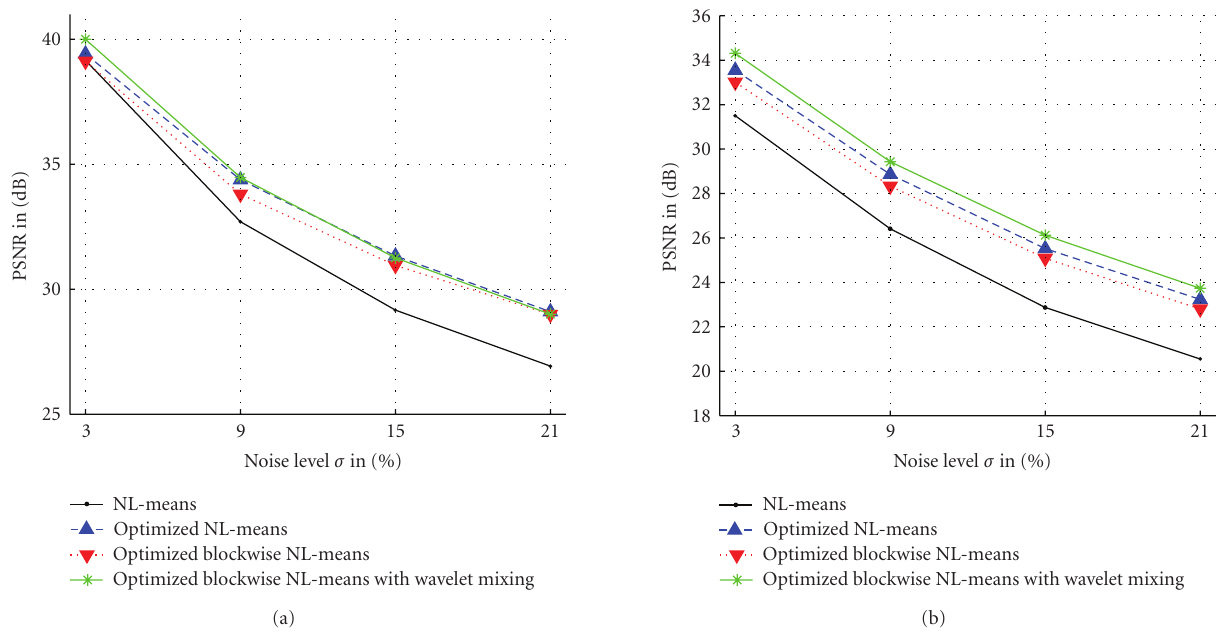
Figure 5: Comparison of the di ff erent NL-means filters on T1-w phantom MRI and T2-w phantom MRI with